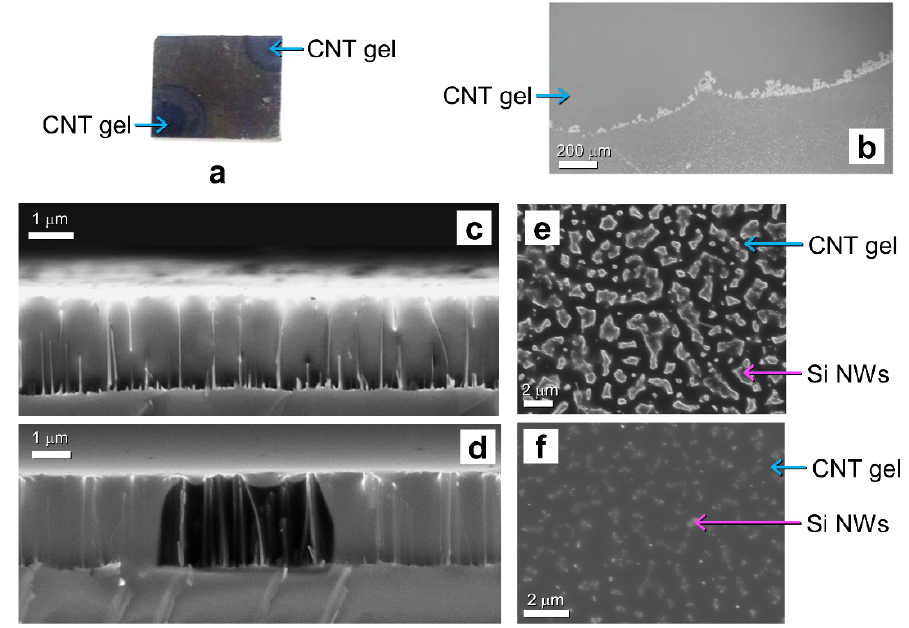
Figure 3. ( a ) Photo of the Si NW sample right after the application of the CNT gel at the two opposite corners. The NW sample in the photo had a dimension of 1 × 1 cm 2 . ( b ) Plan-view scanning electron microscopy during the diffusion of the CNT gel across the NW network. Cross-section SEM image of the hybrid CNT/NW platform ( c ) before and after ( d ) electron beam exposure. Plan view SEM image at the ( e ) beginning of the CNT gel diffusion process and ( f ) after 10 min, respectively. The evolution of the infiltration process in the dense network of NWs was monitored